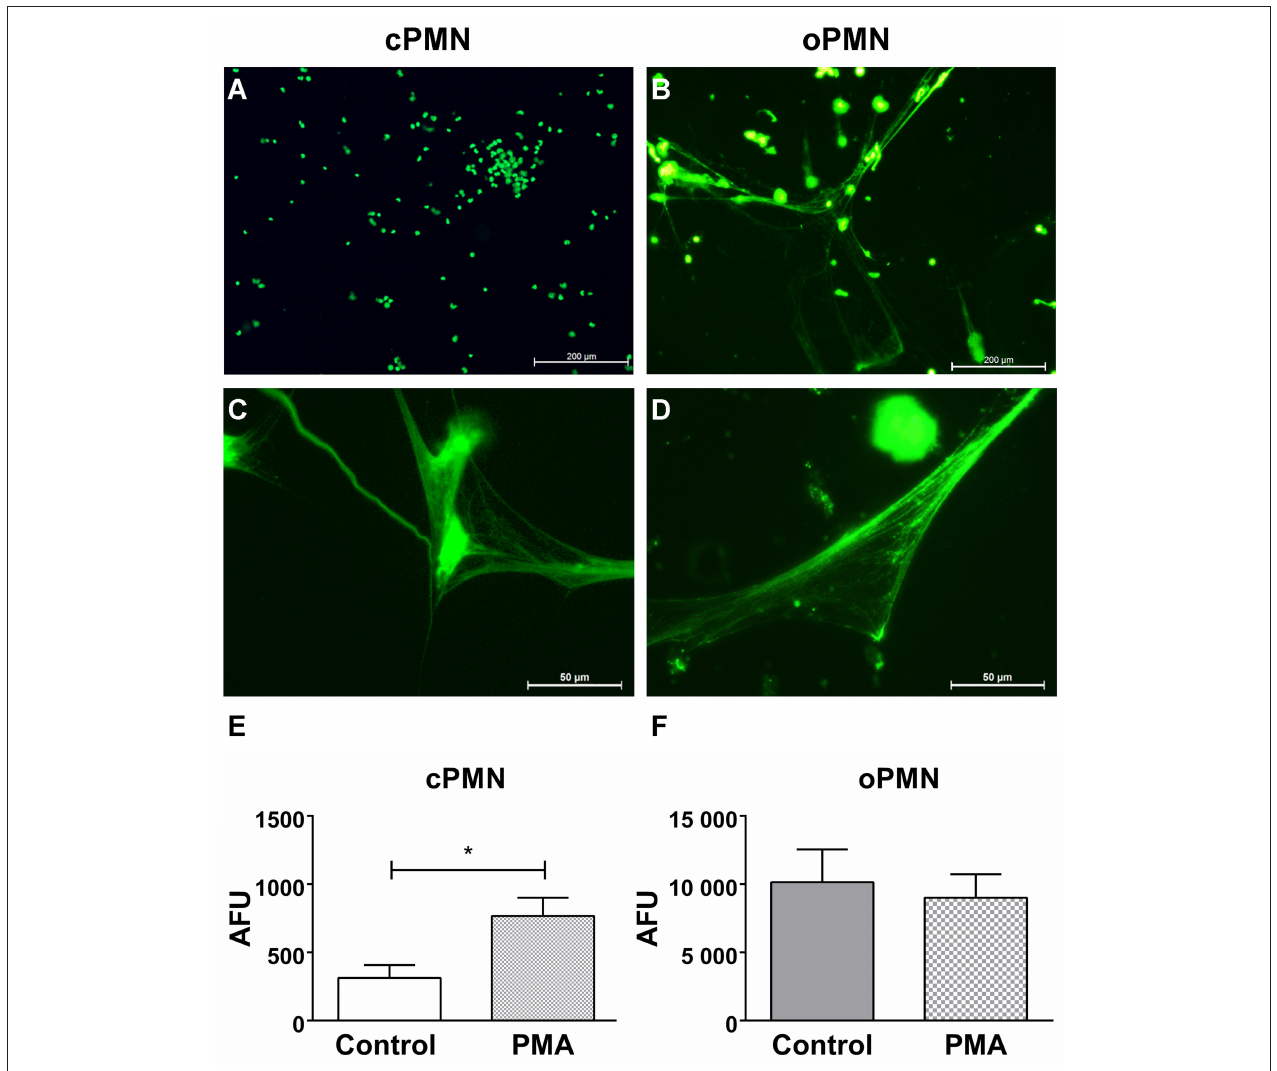
FIGURE 7 | NET formation by unstimulated and stimulated cPMNs and oPMNs. Micrographs of cPMNs (left panels) and oPMNs (right panels) under unstimulated (A,B) and stimulated conditions (C,D) . Significant differences are observed for cPMNs between unstimulated (control, white bar) and stimulated (PMA, gray bar) conditions (E) . All micrographs are representatives of 9 independent experiments. No significant difference ( p = 0.70) was observed between unstimulated (control, gray bar) and stimulated (pattern, PMA) conditions of oPMN NET formation (F) . Quantitative NET formation data are presented as mean ( + SEM) arbitrary fluorescent units (AFU), note the variation in y-axis scales. n = 9, * p <